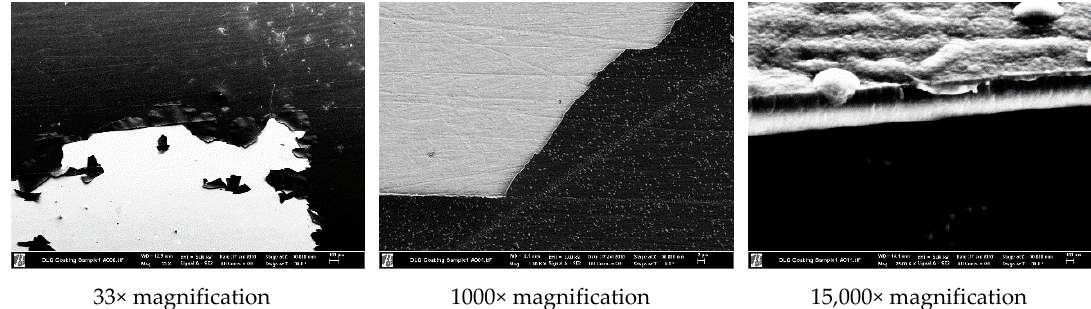
Figure 5. Scanning electron microscopy (SEM) images of the DLC coating failure.